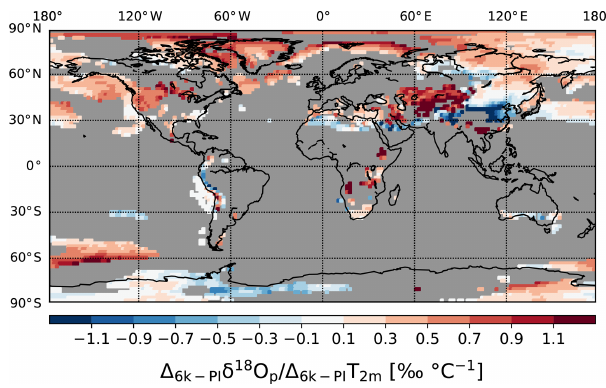
Figure 11. Spatial distribution of the calculated temporal 6k–PI δ 18 O p – T gradients for all grid cells in which (i) simulated annual mean temperature for both PI and 6k is lower than 20 ◦ C and (ii) ab- solute change in temperature between the 6k and PI control simula- tions is at least 0.5 ◦ C. The gradients are calculated in the same way as in Fig. 10b but with the use of precipitation-weighted tempera- tures instead of arithmetic annual mean temperatures.